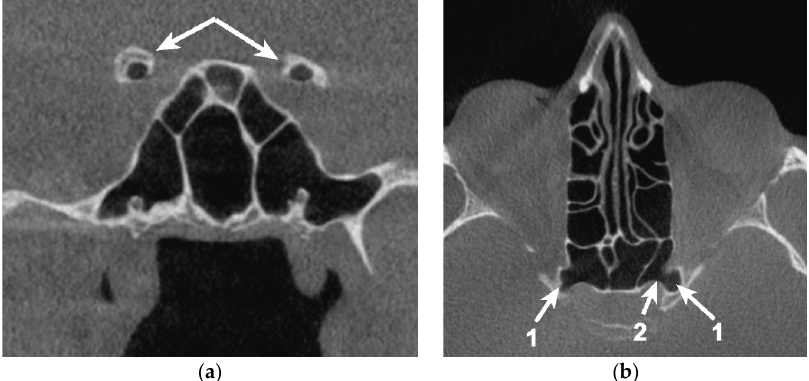
Table 3. Origin and symmetry of the pneumatization from the paranasal sinuses within the optic strut. ONC—Onodi cell. N = 54 cases.